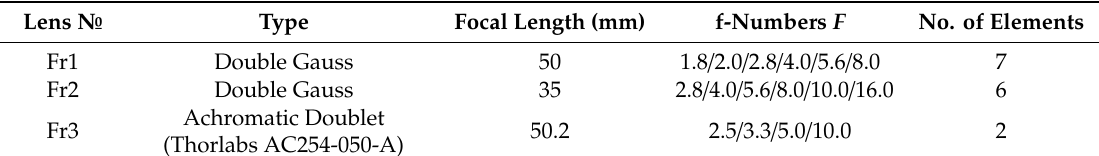
Table 8. Camera lenses modeled using the optical engineering software FRED.